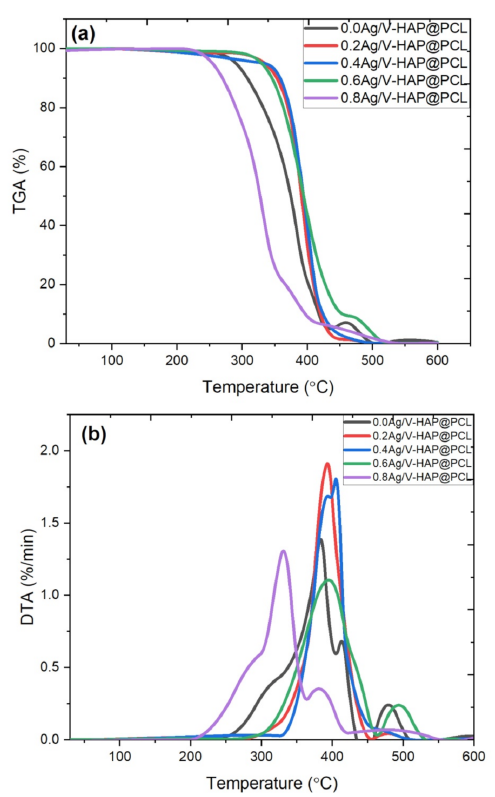
Figure 10. Thermogravimetric analysis of the nanofibers of HAP@PCL at different concentrations of doped ions of Ag/V, including ( a ) TGA and ( b )